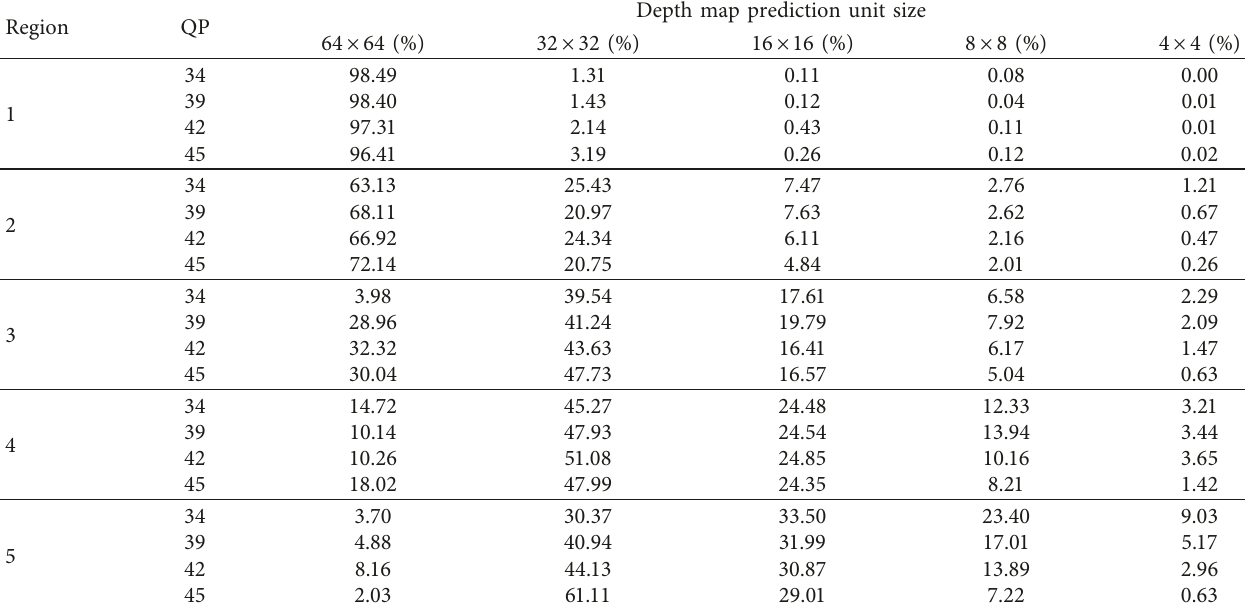
Table 3: The results of the distribution process for all depth map QPs.